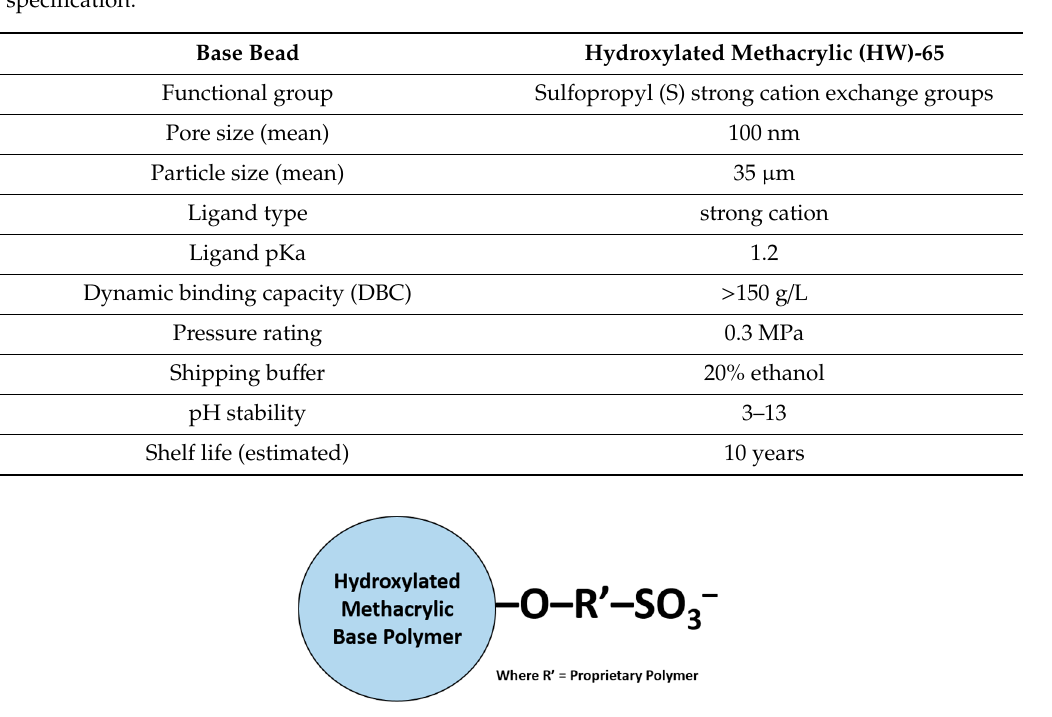
Figure 1. Chemical structure of the acrylic-based sulfopropyl microspheres.